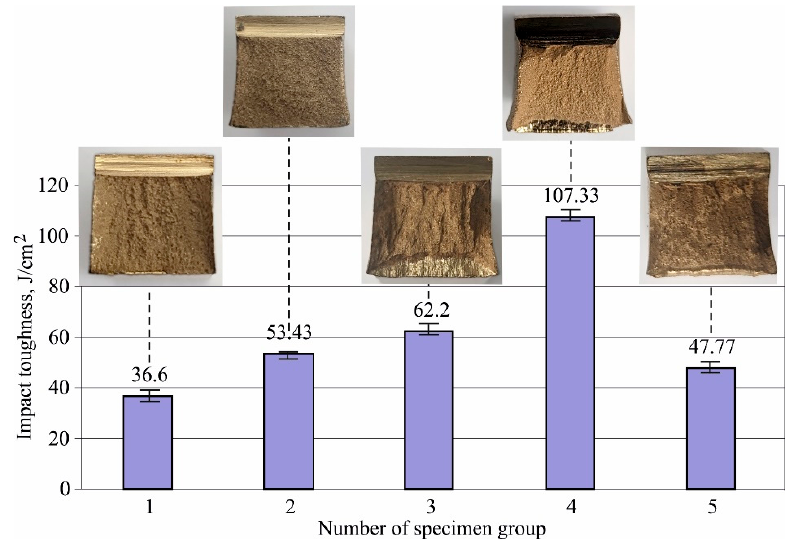
Figure 9. Effect of the heat treatment on impact toughness of Cu-10Al-5Fe bronze: 1—as received, 2—annealed, 3—quenched, 4—quenched and tempered at 600 °C, 5—quenched and tempered at 300 °C.